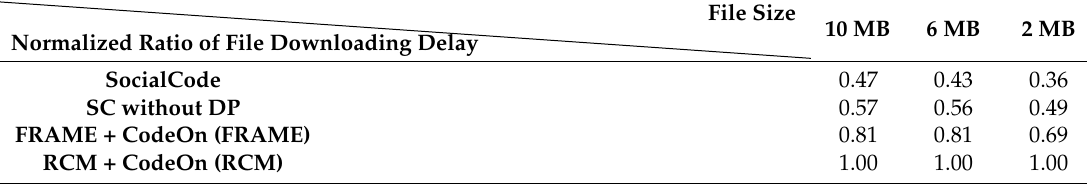
Table 5. Normalized ratios for average file downloading delays of SocialCode, SC without DP